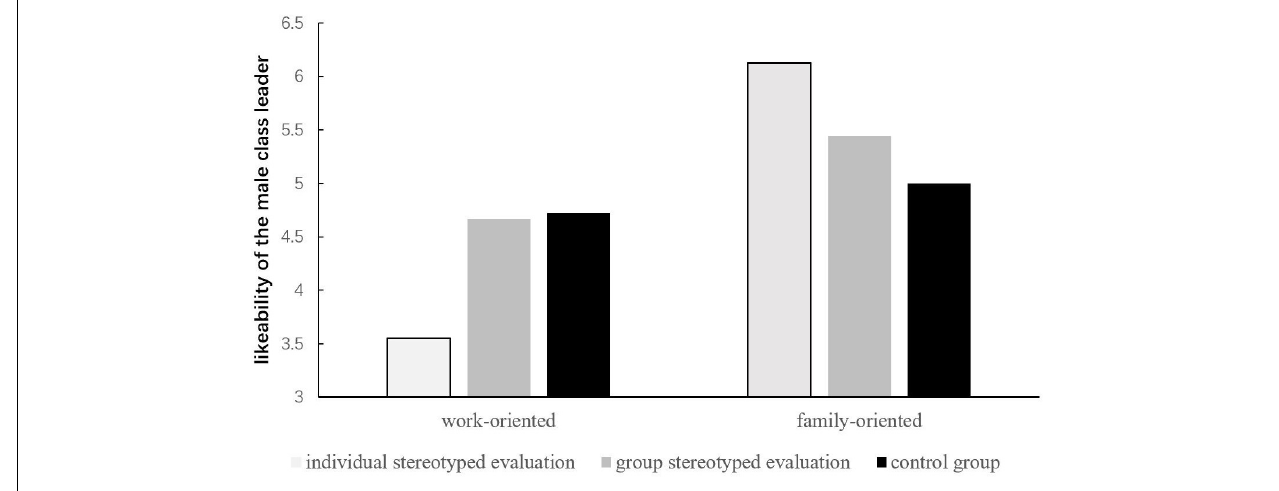
FIGURE 2 | Likeability of the male leader who evaluated the women base on the positive stereotype by work-oriented and family-oriented women.